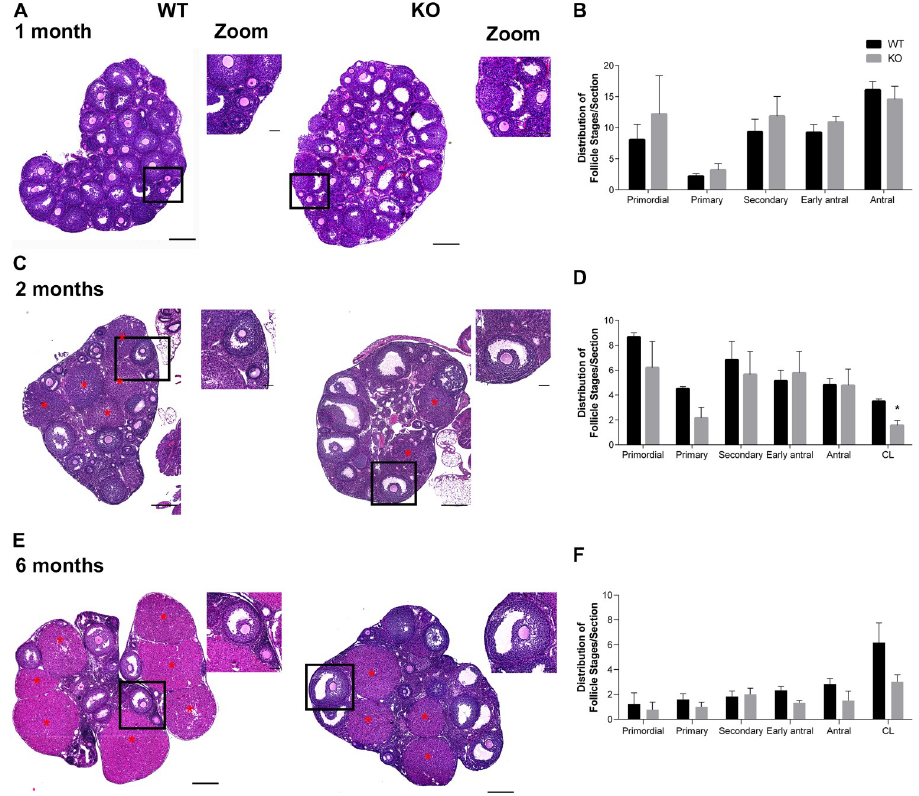
Fig 2. Aurka KO females have normal follicle development. (A, C, E) Representative images of hematoxylin/eosin- stained ovarian sections from WT and Aurka knockout (KO) females from different ages: 1 month (A) ; 2 months (C) ; 6 months (E ), red asterisks: corpus luteum (CL). The zoom panels highlight commonly observed follicles at each age. (B, D, F) Quantification of follicle types from the ovaries represented in (A, C, E) respectively. Follicle numbers were quantified for each ovary and reported as the average number of each type of follicles per section. � p < 0.05. Graph shows the mean ± SEM (1 and 6 months: 3 females/genotype, 2 months: 2 WT; 3 KO). Scale bars: 50 μ m (zoom panels) and 200 μ